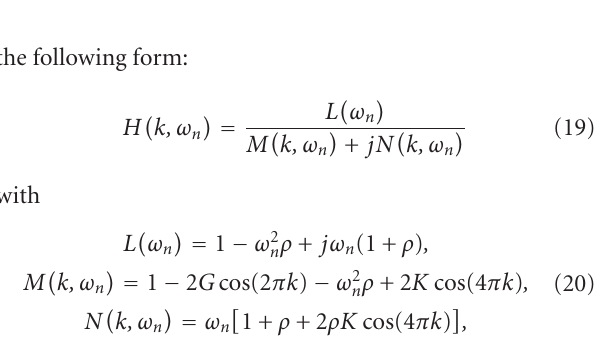
Figure 5: (a) The magnitude and (b) phase plots for the even and odd temporal filters used ( ω 0 = 6 π rad/s and τ = 0 . 13 s).